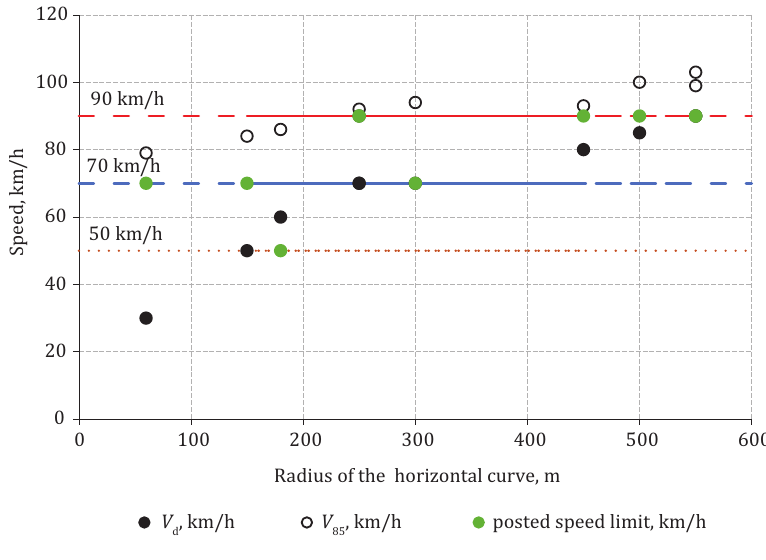
Figure 5. Measured V 85, V d and posted speed limit in comparison to various radius of horizontal